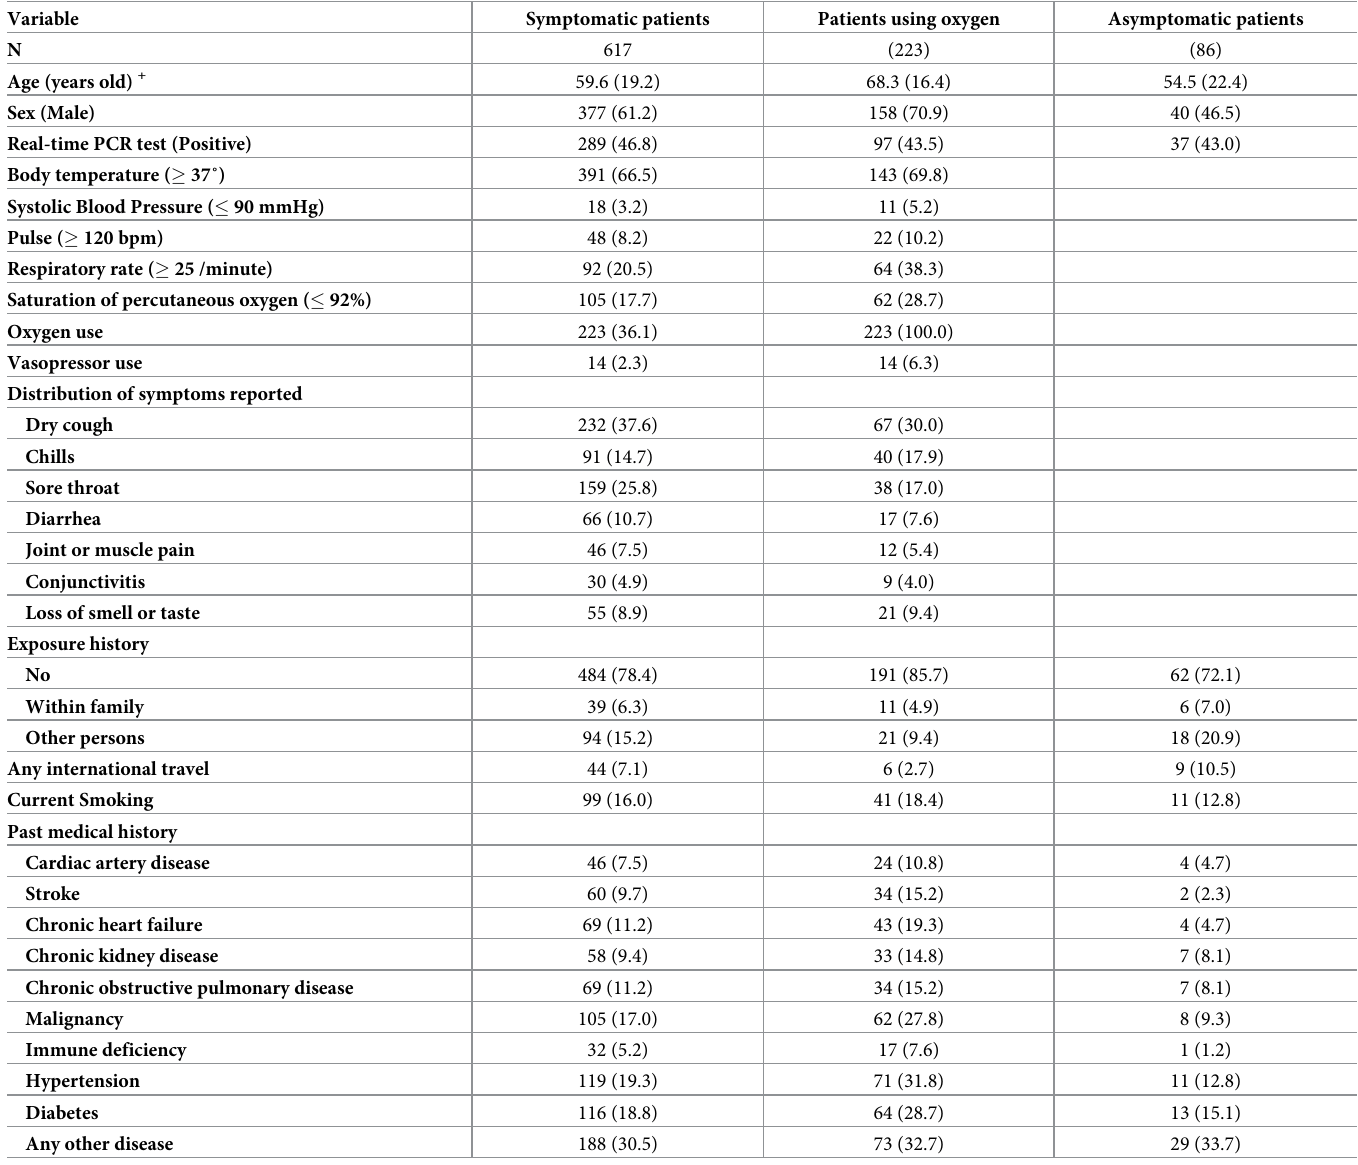
Table 1. Demographics of patient